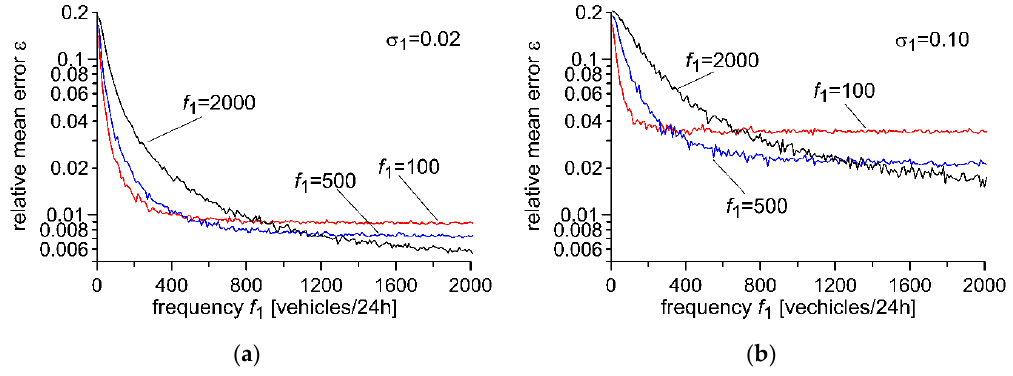
Figure 7. Impact of frequency f 1 in the area of the optimal point after optimisation of the autocalibration algorithm for a set frequency of flow of reference vehicles f 1 and for a set relative standard deviation of uncertainty σ 1 of the reference value. ( a ) Optimisation for σ 1 = 0.02, ( b ) Optimalization for σ 1 = 0.10.